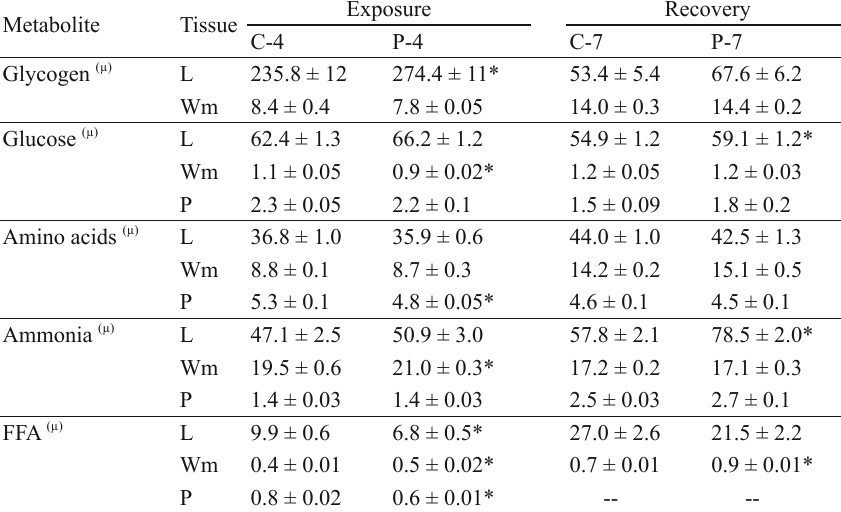
Concentration of metabolites in the Ictalurus punctatus exposed to